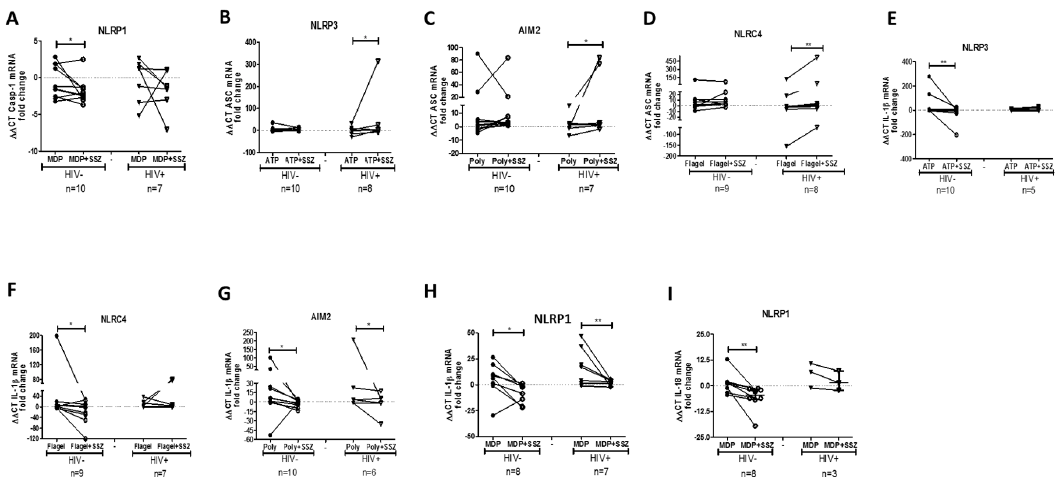
Figure 3. Expression of inflammasome-related genes in peripheral blood mononuclear cells (PBMCs) in response to sulfasalazine (SSZ). The expression of inflammasome-related gene was quantified by qPCR in the PBMCs from healthy and people living with HIV, which were stimulated with inflammasome agonists (ATP 2 mM for NLRP3; Flagellin 500 ng / mL for NLRC4; poly(dA;dT) 50 µ g / mL for AIM2;